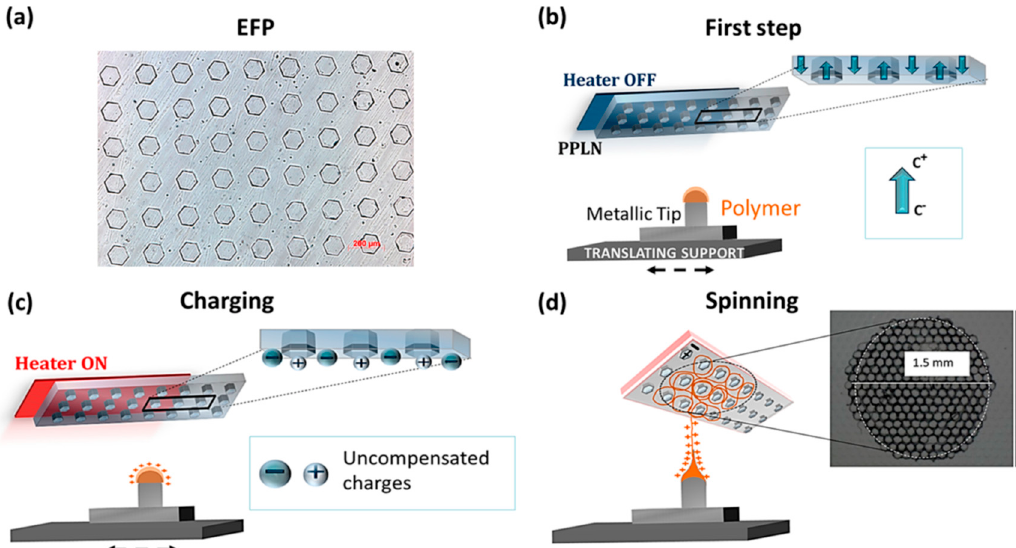
Figure 8. Schematic illustration of the bipolar pyroelectrospinning process. ( a ) Optical microscope image of the periodically poled lithium niobate (PPLN) crystal plate, ( b ) the pyroelectrospinning with heat-off and ( c ) with heat-on where the PPLN plate becomes charged. The polymer droplets exhibit positive charges to deform into Taylor cone. ( d ) The ejected nanofibers collected on the region surrounding the hexagons, and the SEM image of the resulting pattern array in the nanofiber mat. [Adapted with permission from 81. Copyright (2019) American Chemical Society].